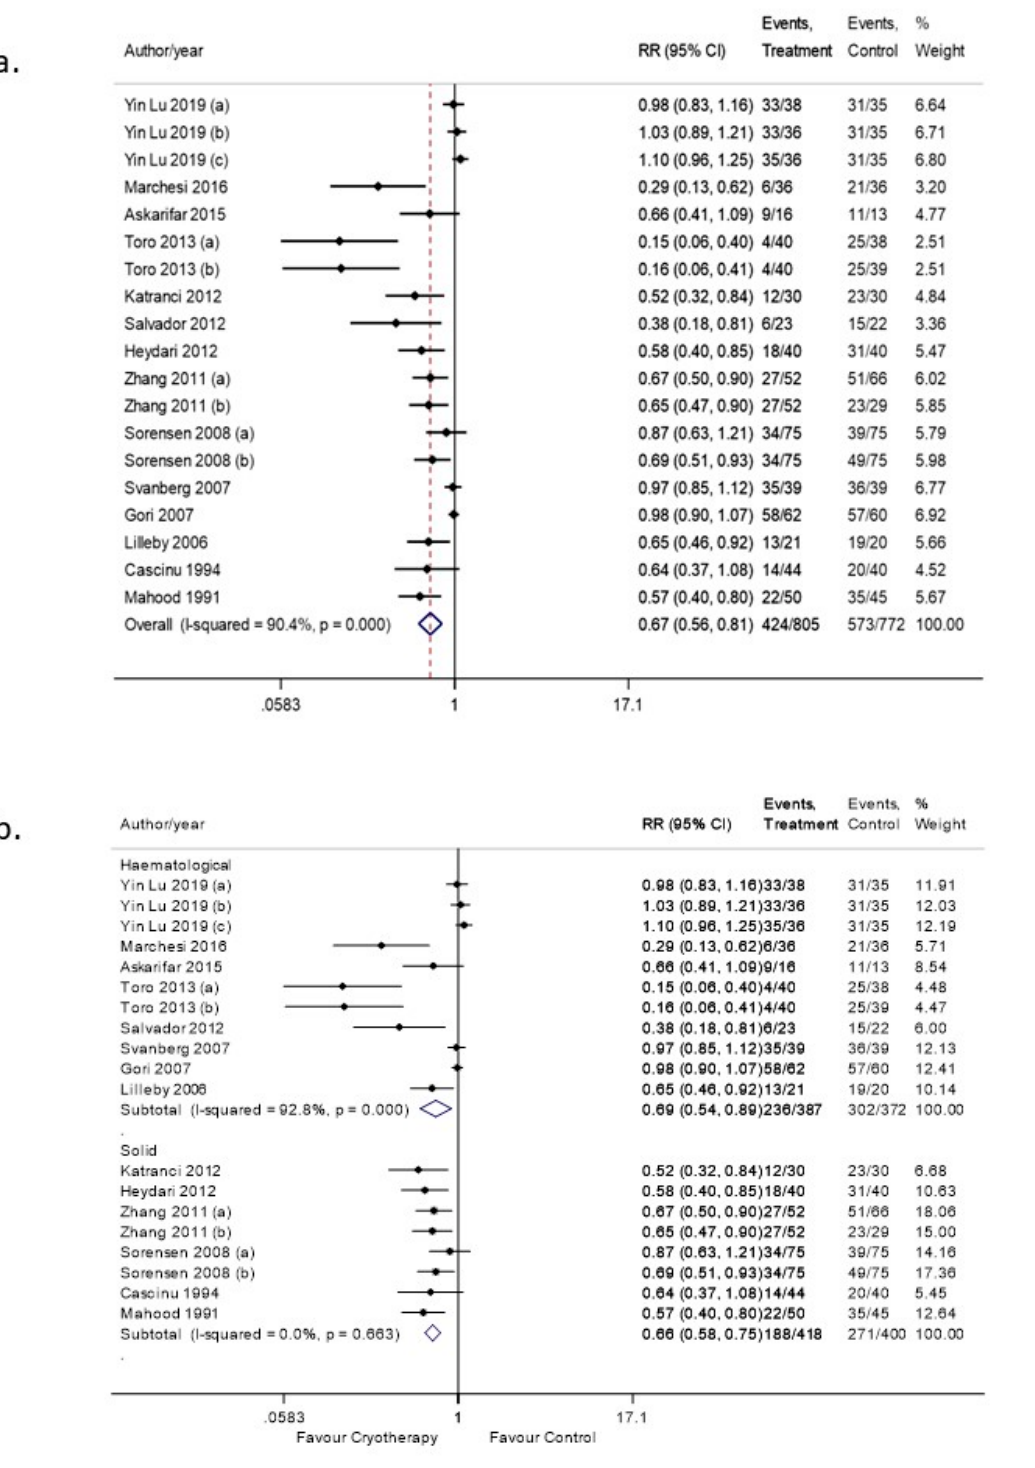
Figure 2. ( a ) Forest plot illustrating pooled data on the effects of OC on the incidence of OM (any grade). ( b ) Forest plot illustrating subgroup analysis according to type of malignancy.